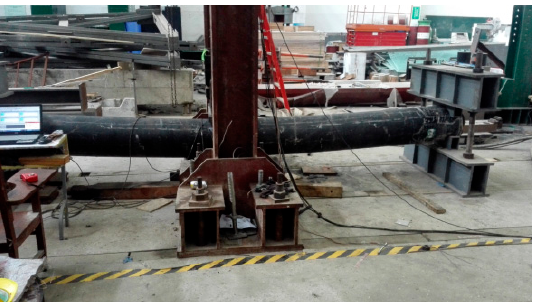
Figure 8. The test phenomenon of the BFRPC composite column specimen.